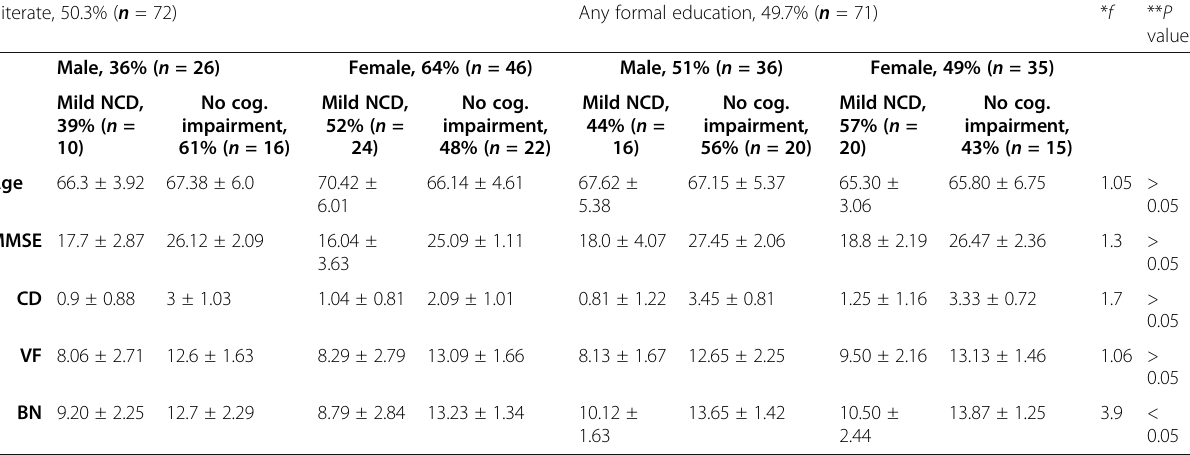
Table 2 Performance in neurocognitive tools according to education level Illiterate, 50.3% ( n = 72) Any formal education, 49.7% ( n = 71)